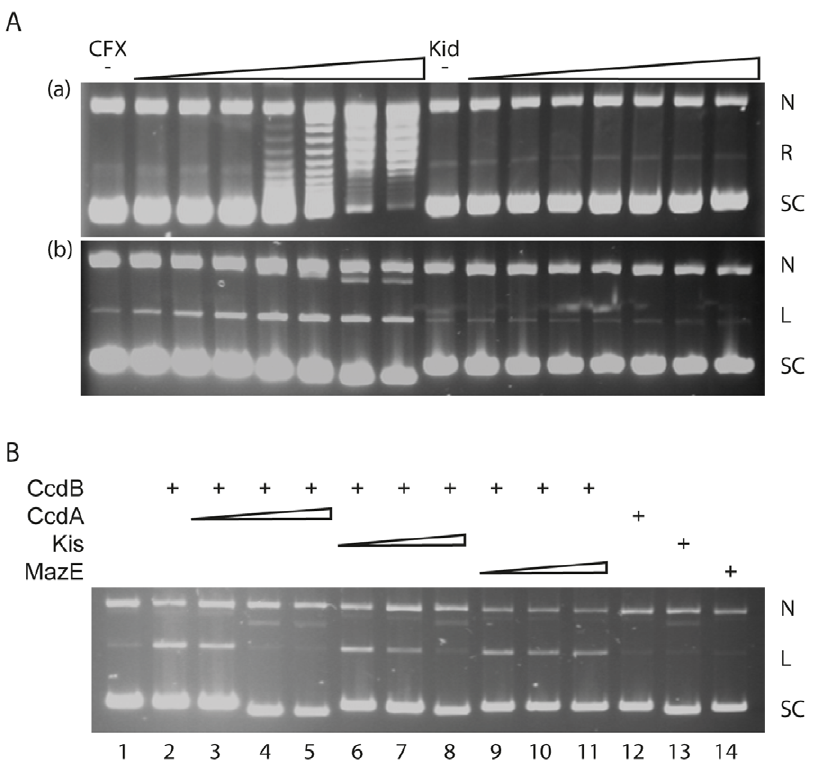
Figure 4. Evaluation of DNA gyrase activity in the presence of different toxins and antitoxins. (A) Kid does not inhibit the action of DNA gyrase. Relaxed pBR322 (21 nM) was incubated with 30 nM gyrase, ATP (1.4 mM) and various concentrations of CFX (ciprofloxacin; 0, 0.1, 0.2, 0.5, 1, 2, 5 and 10 m M) and Kid (0, 0.1, 0.2, 0.5, 1, 2, 5 and 10 m M) as indicated, for 1 h at 37 u C. Assays were either (a) stopped or (b) cleaved DNA was revealed by the addition of SDS and proteinase K and incubation at 37 u C for 30 mins. Reactions were stopped with 40% sucrose, 100 mM Tris ? HCl (pH 7.5), 100 mM EDTA, 0.5 mg/ml bromophenol blue, and samples were subjected to phenol extraction and analysed on a 1% agarose gel (a) run in the absence of ethidium bromide or (b) run in the presence of ethidium bromide (1 m g/mL). N, nicked DNA; L, linear DNA; SC, supercoiled DNA; R, relaxed DNA. (B) Kis, but not MazE, can inhibit the action of CcdB. Relaxed pBR322 (21 nM) was incubated with 30 nM DNA gyrase, ATP (1.4 mM) and various concentrations of CcdB (2 m M), CcdA (1, 2 & 4 m M), Kis (2, 20 & 40 m M) or MazE (2, 20 & 40 m M) as indicated, at 37 u C for 1 h. Toxin-antitoxin ratios were 1:0.5, 1:1, 1:2 in Tracks 3–5 and 1:1, 1:10, 1:20 in Tracks 6–8 & 9–11. Antitoxin only controls were at highest concentration used (Tracks 12–14). Cleaved DNA was revealed by the addition of SDS and proteinase K and incubation at 37 u C for 30 mins. Reactions were stopped with STEB, and samples